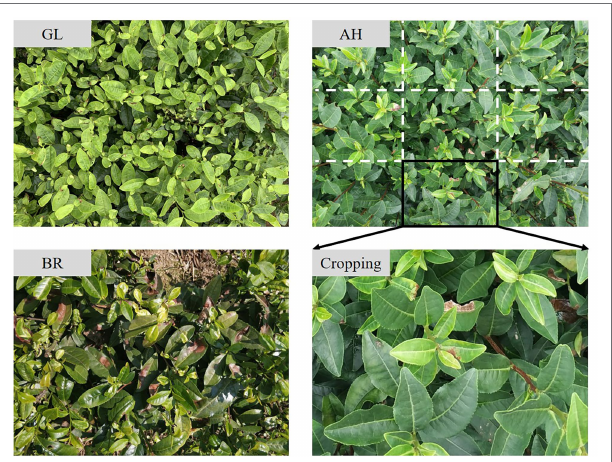
FIGURE 1 | The RGB image of tea plant stresses.